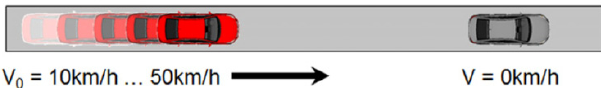
Figure 5. AEBS City Scenario of Euro NCAP Test Method. Figure 5. AEBS C ity Scenario of Euro NCAP Test Method.